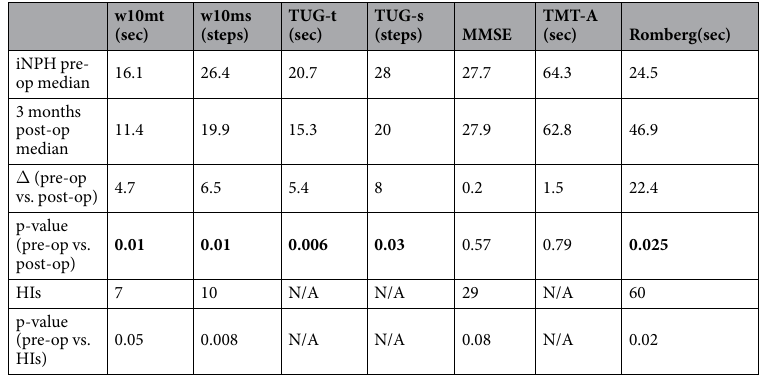
Table 2. Motor and cognitive results of iNPH patients (before and after shunt surgery) and HIs. pre-op: pre- operative patients; post-op: post-operative patients.